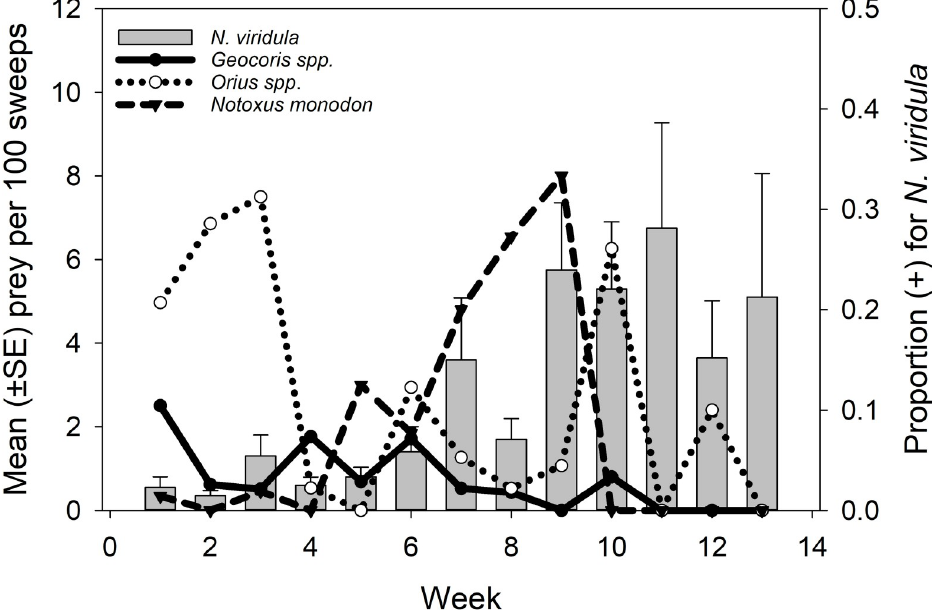
Fig 2. 2012 Gut content results. Mean ( ± SE) number of N . viridula per 100 sweeps and the proportion Geocoris spp , Orius spp , and N . monodon . testing positive for N . viridula DNA by sampling week, 12 July– 11 October